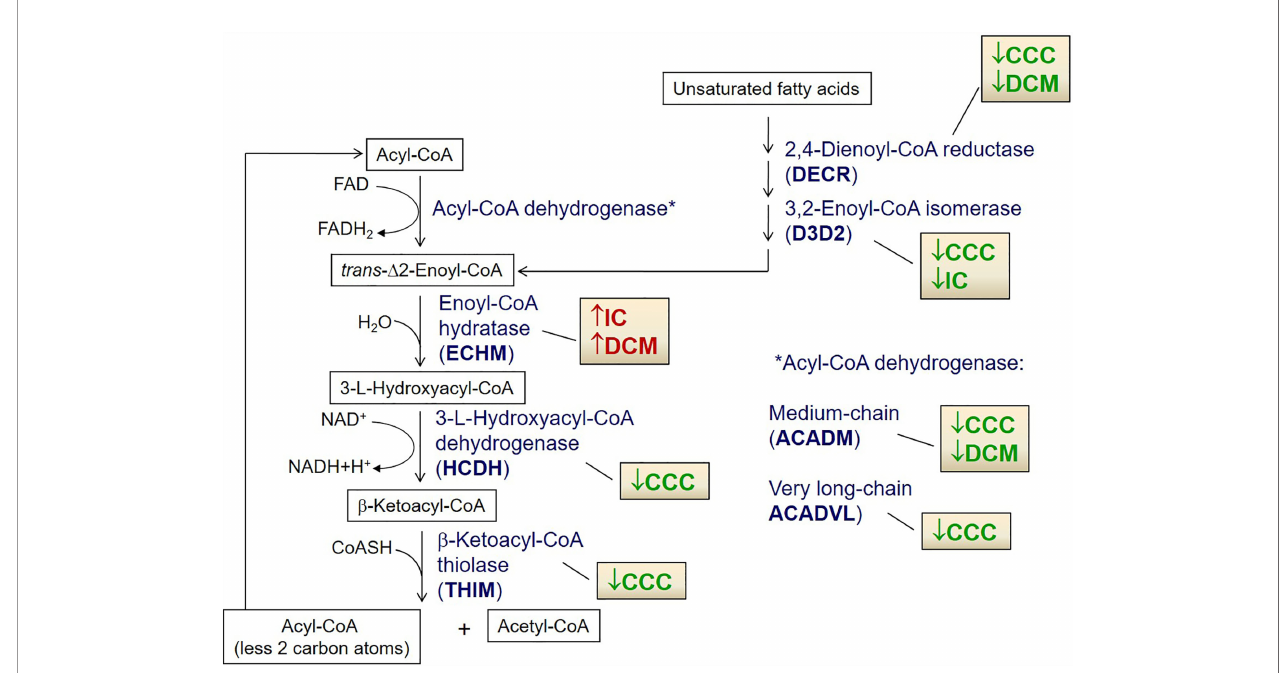
FIGURE 3 | Cartoon depicting fatty acid b -oxidation enzymes differentially expressed in CCC, DCM and IC myocardium. Arrows indicate up-regulated (red) or down-regulated (green) expression as compared to control myocardial samples in the proteomic analysis. *Indicates the right place for in the metabolic pathway for Acyl coA dehydrogenases ACADVL and